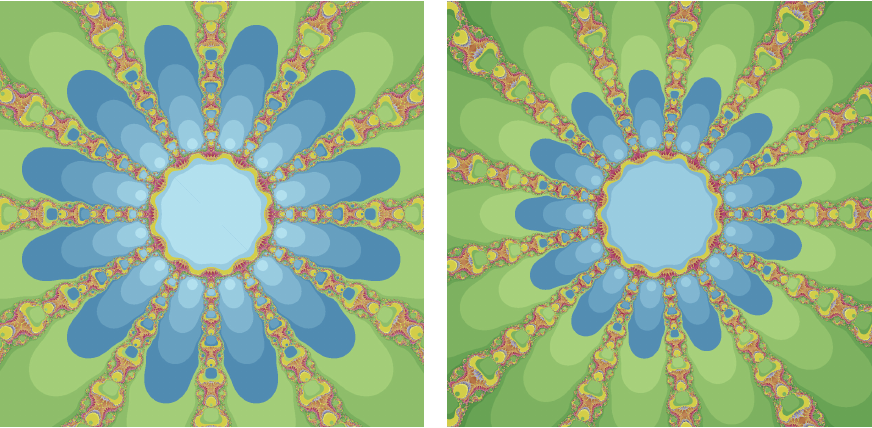
Figure 4: The fractal pictures obtained by (18) using the polynomials 𝑝(𝑧) = 𝑧 12 + 1 and 𝑝(𝑧) = 𝑧 13 + 1